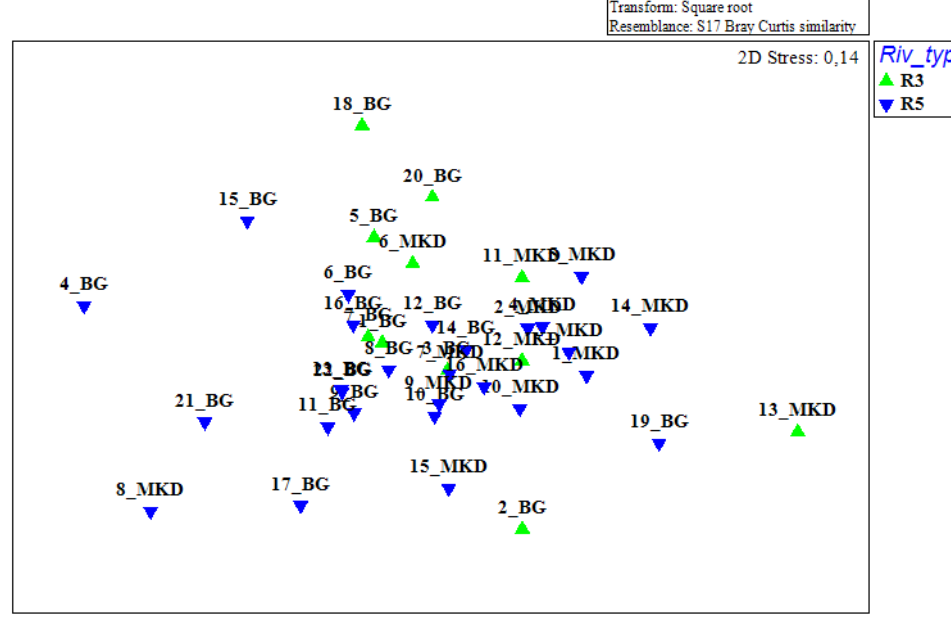
Figure 8. MDS plot of the similarity between the studied mountainous (R3) and semi-mountainous (R5) sites based on their trophic structure (For site codes see Materials and Methods).